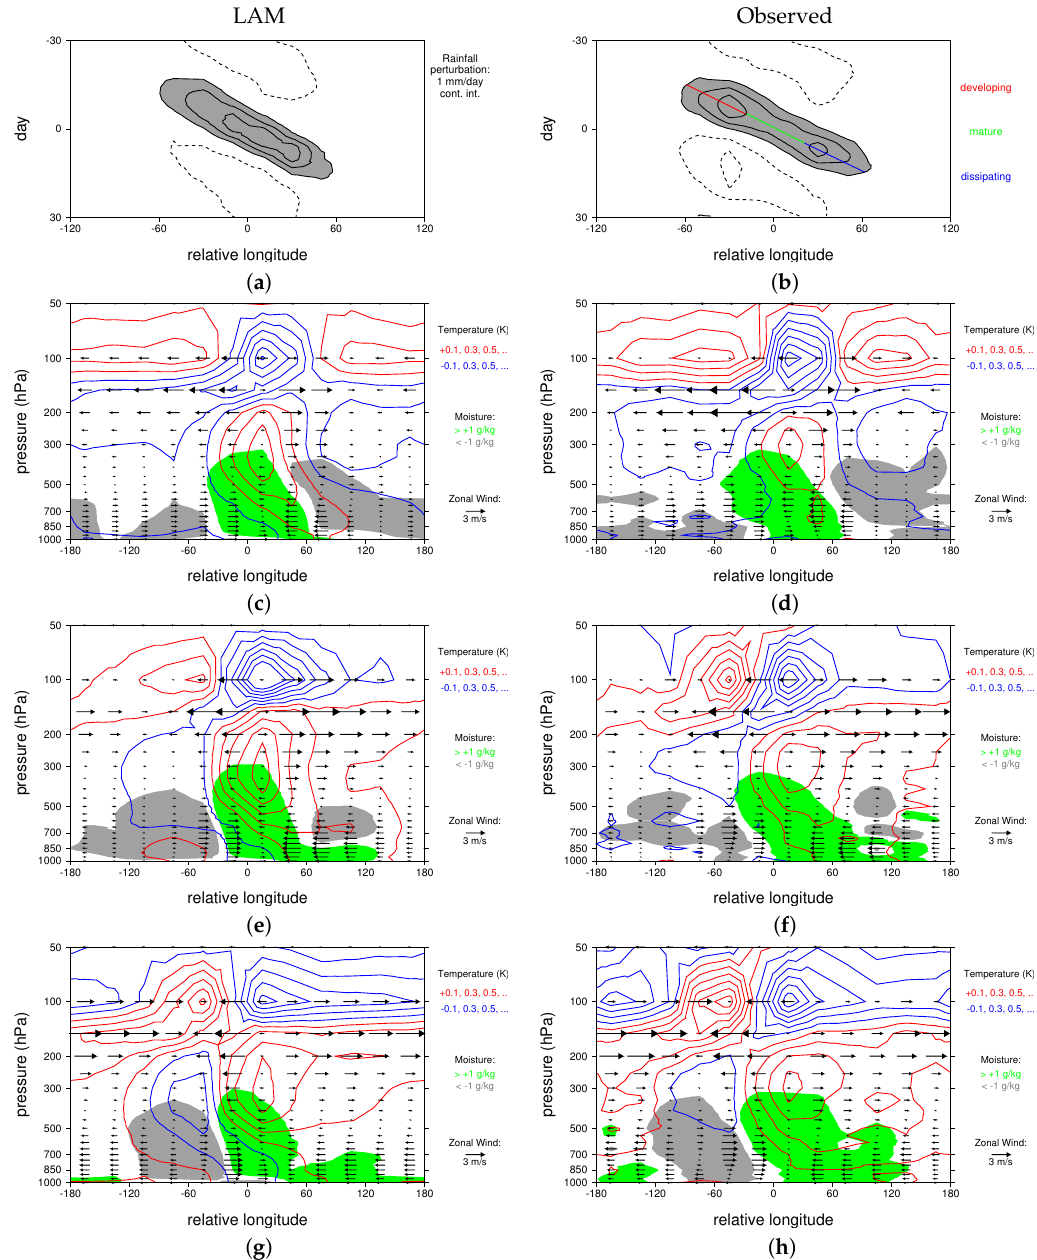
Figure 5. Composite Madden Julian Oscillation for the LAM (left panels) and observations (right panels, adapted from [12]). ( a , b ) rainfall times series (1 mm/day contour interval, perturbations greater than 1 mm/day are shaded gray, and negative contours are dashed). Composite vertical structures for ( c , d ) developing, ( e , f ) mature, and ( g , h ) dissipating stages. Green (gray) shading denotes a positive (negative) moisture anomaly of greater (less) than 1 ( − 1) g/kg. Temperature is contoured with red (blue) contours indicating positive (negative) perturbations. Vectors illustrate the zonal